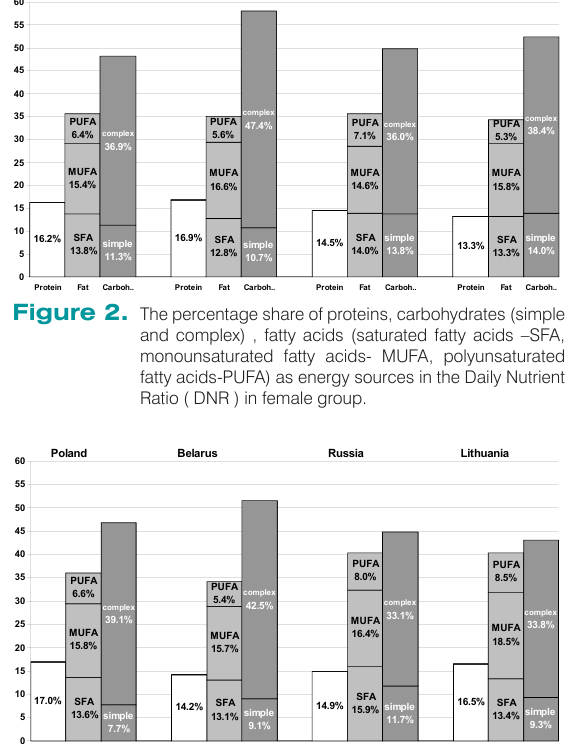
Figure 3. The percentage share of proteins, carbohydrates (simple and complex) , fatty acids (saturated fatty acids –SFA, monounsaturated fatty acids- MUFA, polyunsaturated fatty acids-PUFA) as energy sources in the Daily Nutrient Ratio (DNR) in male